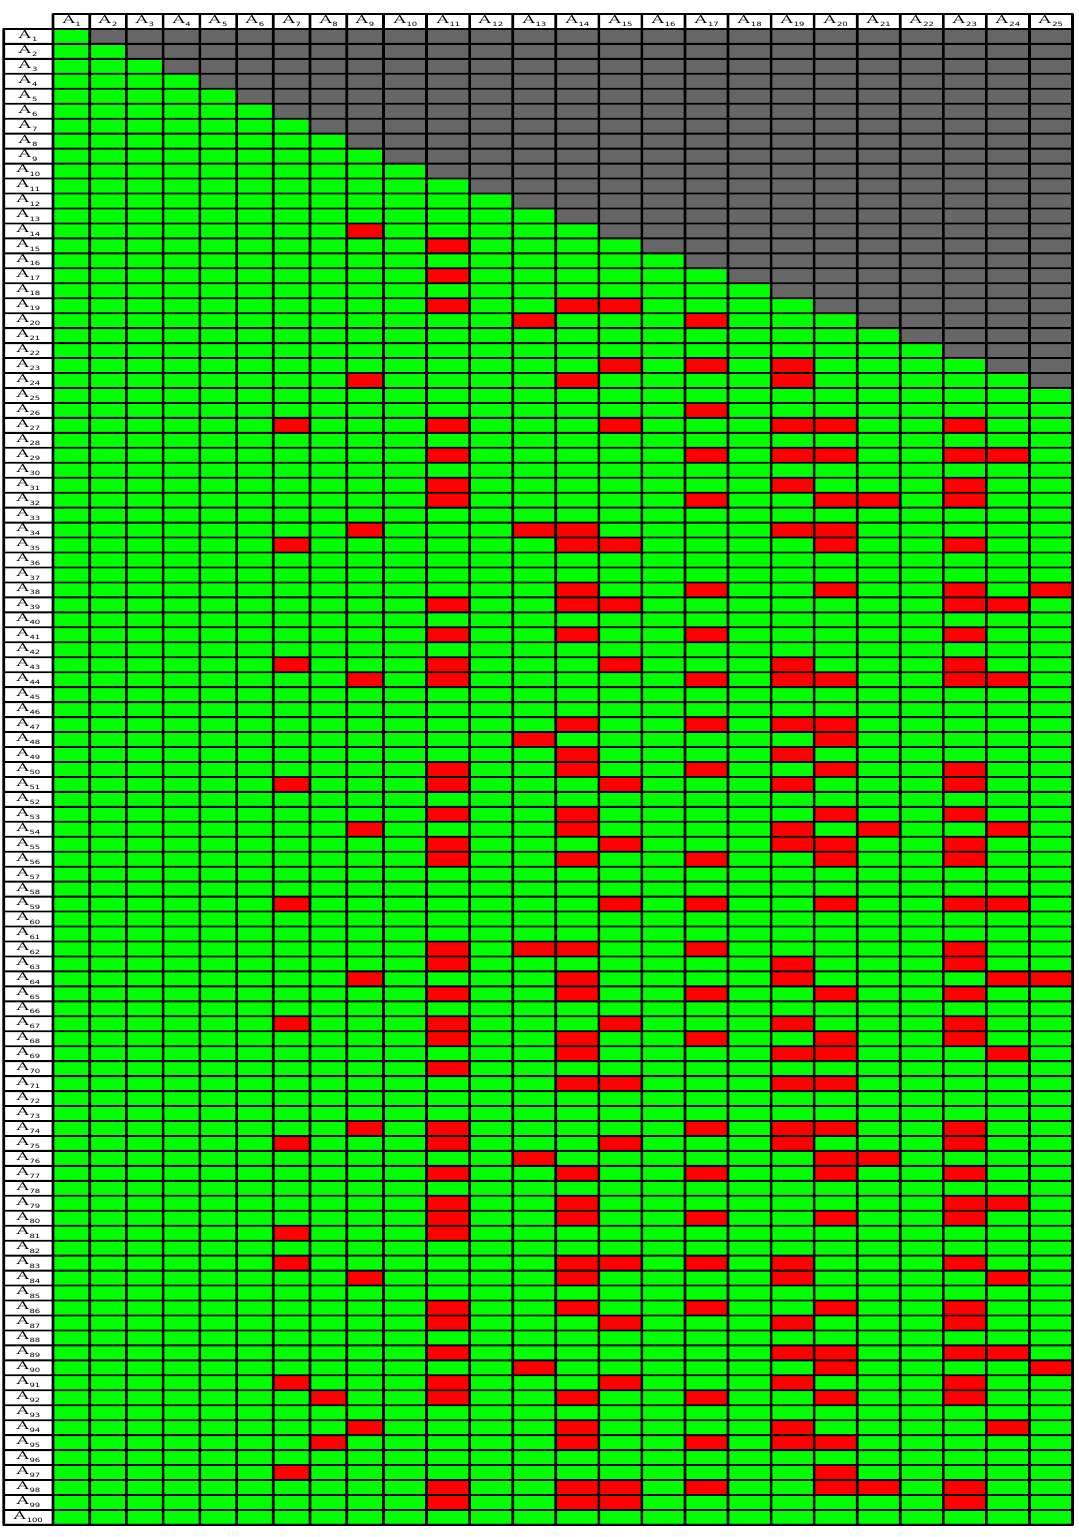
Table 2 . Analyzed theories for ( A n ; A m ) with n = 1 ; : : : 100 and m = 1 ; : : : 25.